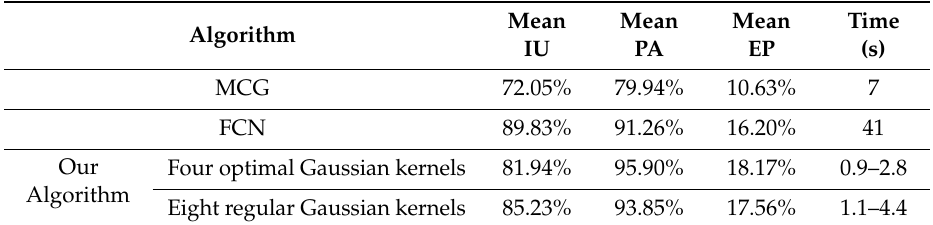
Table 4. Experimental results of di ff erent